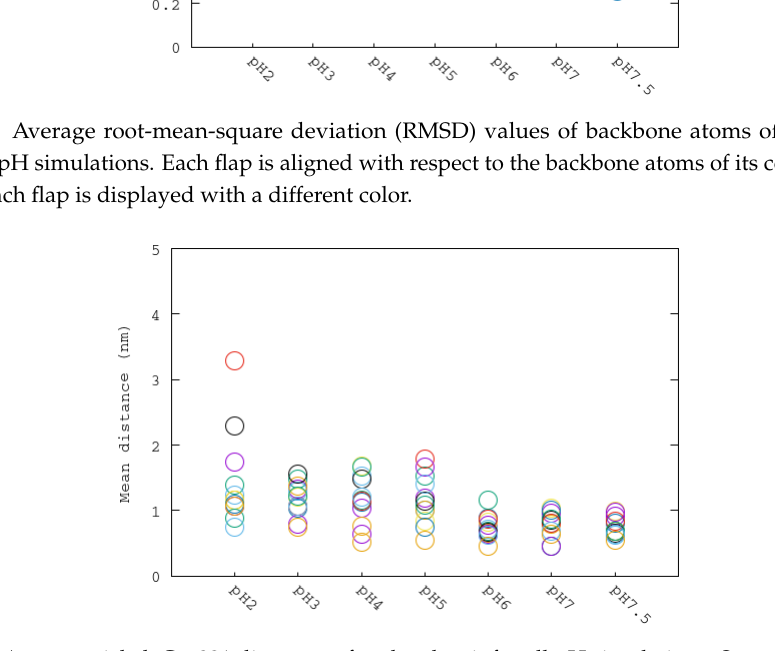
Figure 8. Average nickel–Cys321 distances of each subunit for all pH simulations. Same color code as Figure